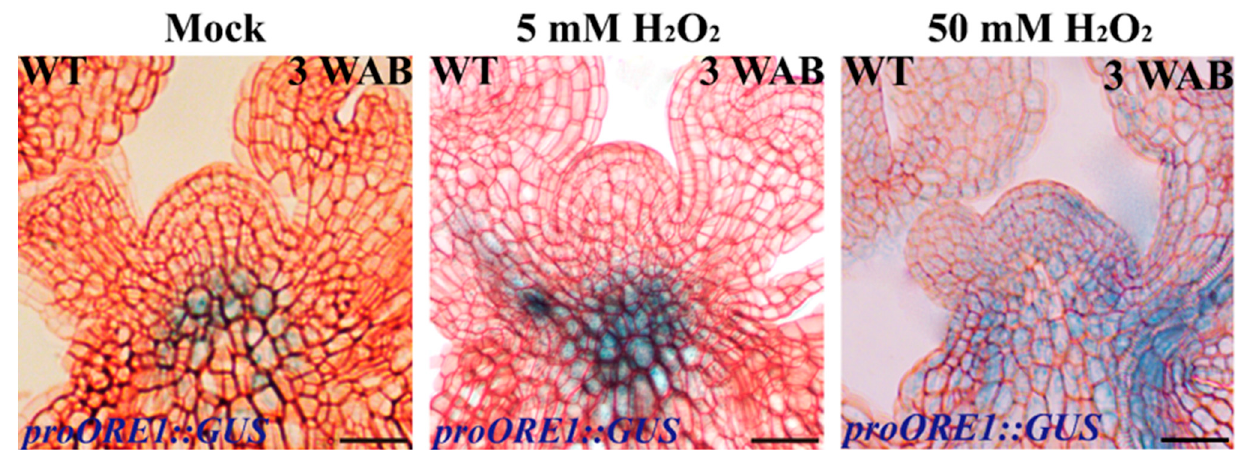
Figure 7 . Effects of exogenous H 2 O 2 on dPCD marker gene ORE1 expression. The IMs at 2 WAB were treated with 5 mM (negative control) and 50 mM H 2 O 2 until 3 WAB. The images show GUS signals of ORE1 at 3 WAB. Scale bars: 20 μ m.